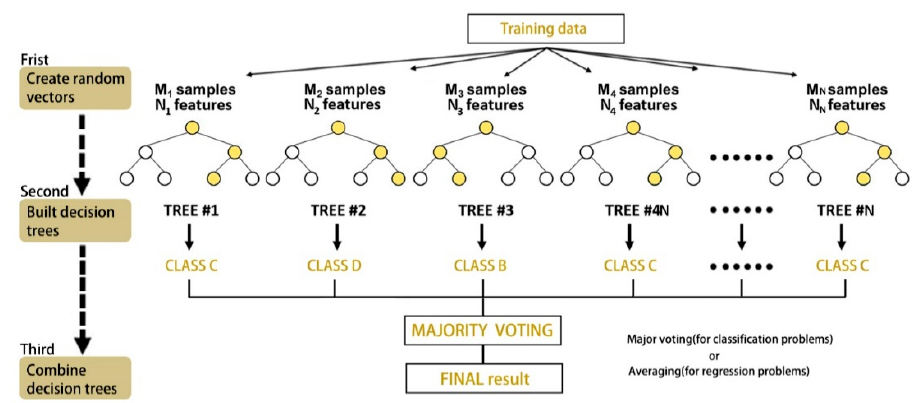
Figure 2. A random forest technique example.